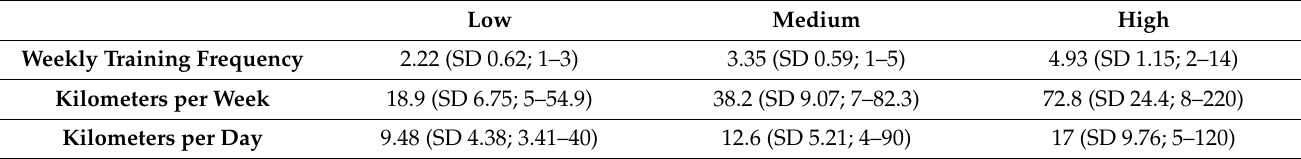
Table 2. Training frequency and mileage displayed by Low, Medium, and High subgroups. Low Medium Weekly Training